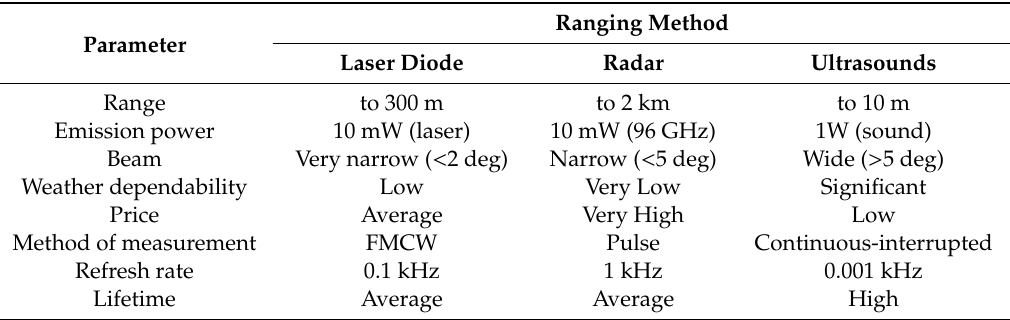
Table 2. Comparison of